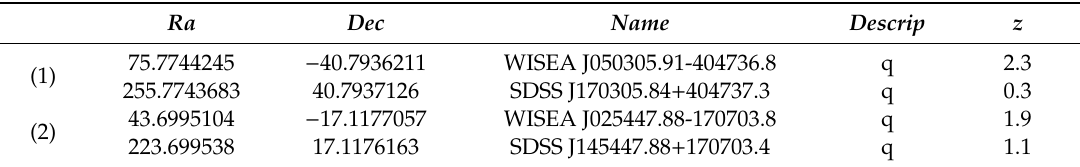
Table 12. Pairs of quasars from Milliquas 6.3 catalog with the best positional accuracy for lens e ff ect. Accuracy is of 0.0001 ◦ for ra and dec . Descrip column is the classification of object, see [47]. Redshift z is given, although not essential